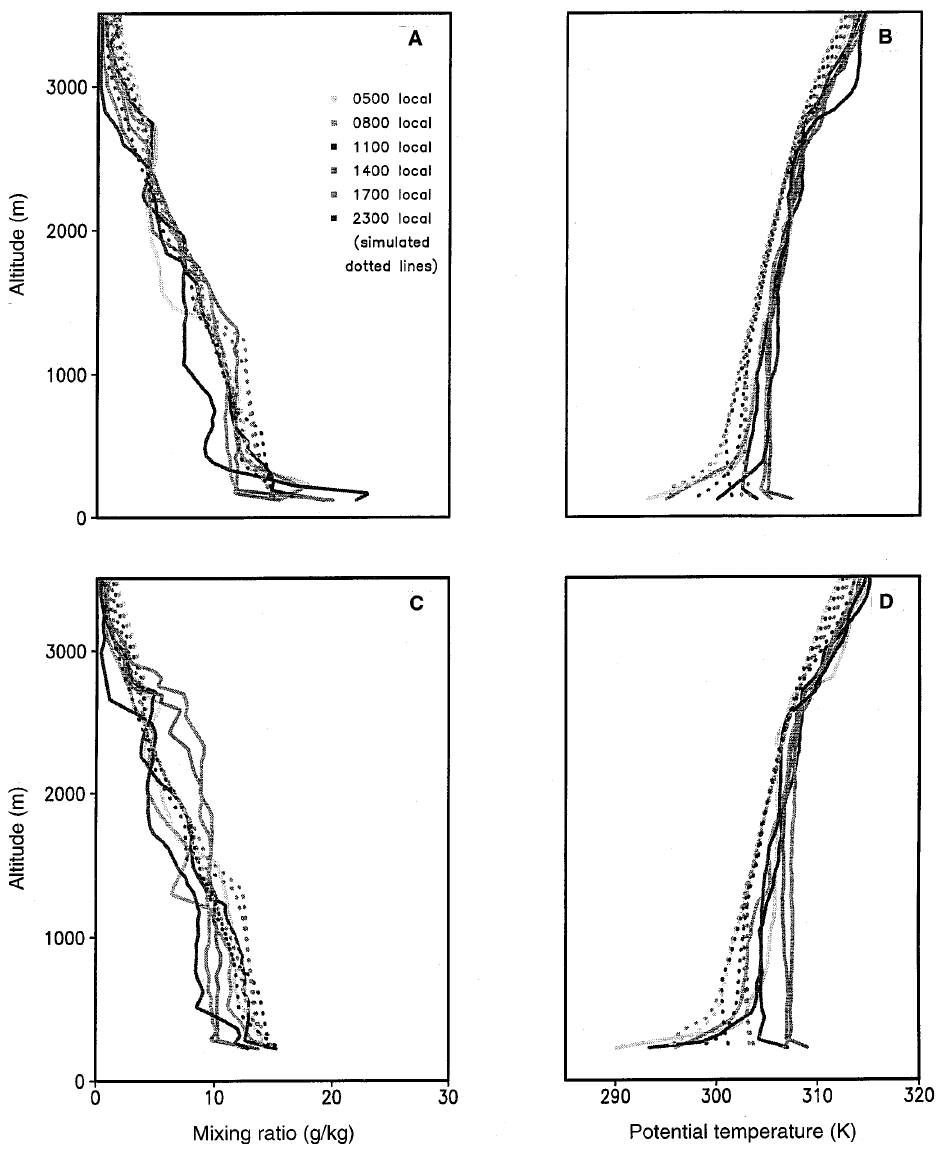
Fig. 10A–D. Simulated ( dotted lines ) and observed ( solid lines ) mixing ratio and potential tem- perature profiles for 19 August for A, B RJF and C, D NSP with the